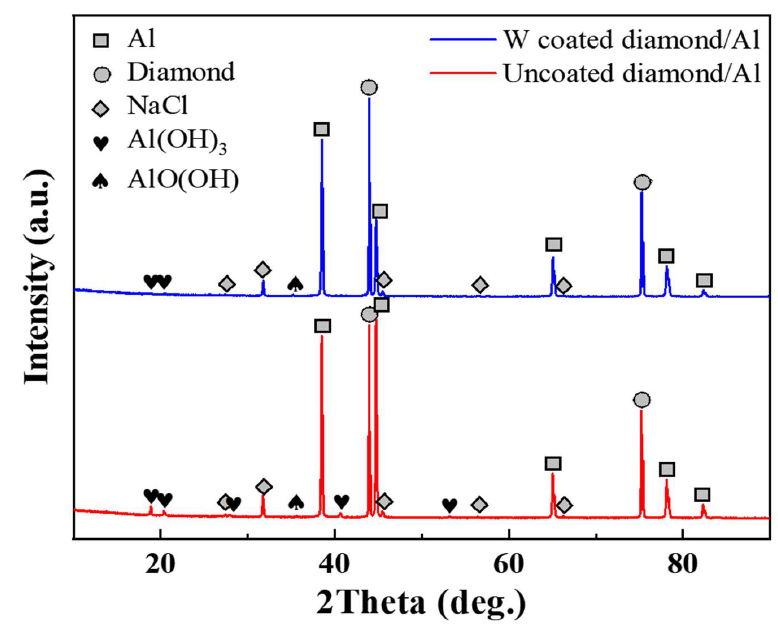
Figure 8. XRD pattern of diamond/aluminum composite after corrosion.